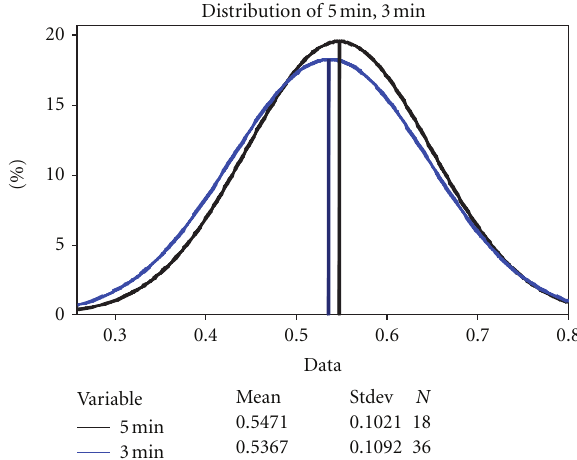
Figure 5: Normal distribution of Pearson correlation coe ffi cients for 5-minute and 3-minute epochs. The x -axis indicates the correlation coe ffi cient and the y -axis indicates the percentage of the related coe ffi cient.